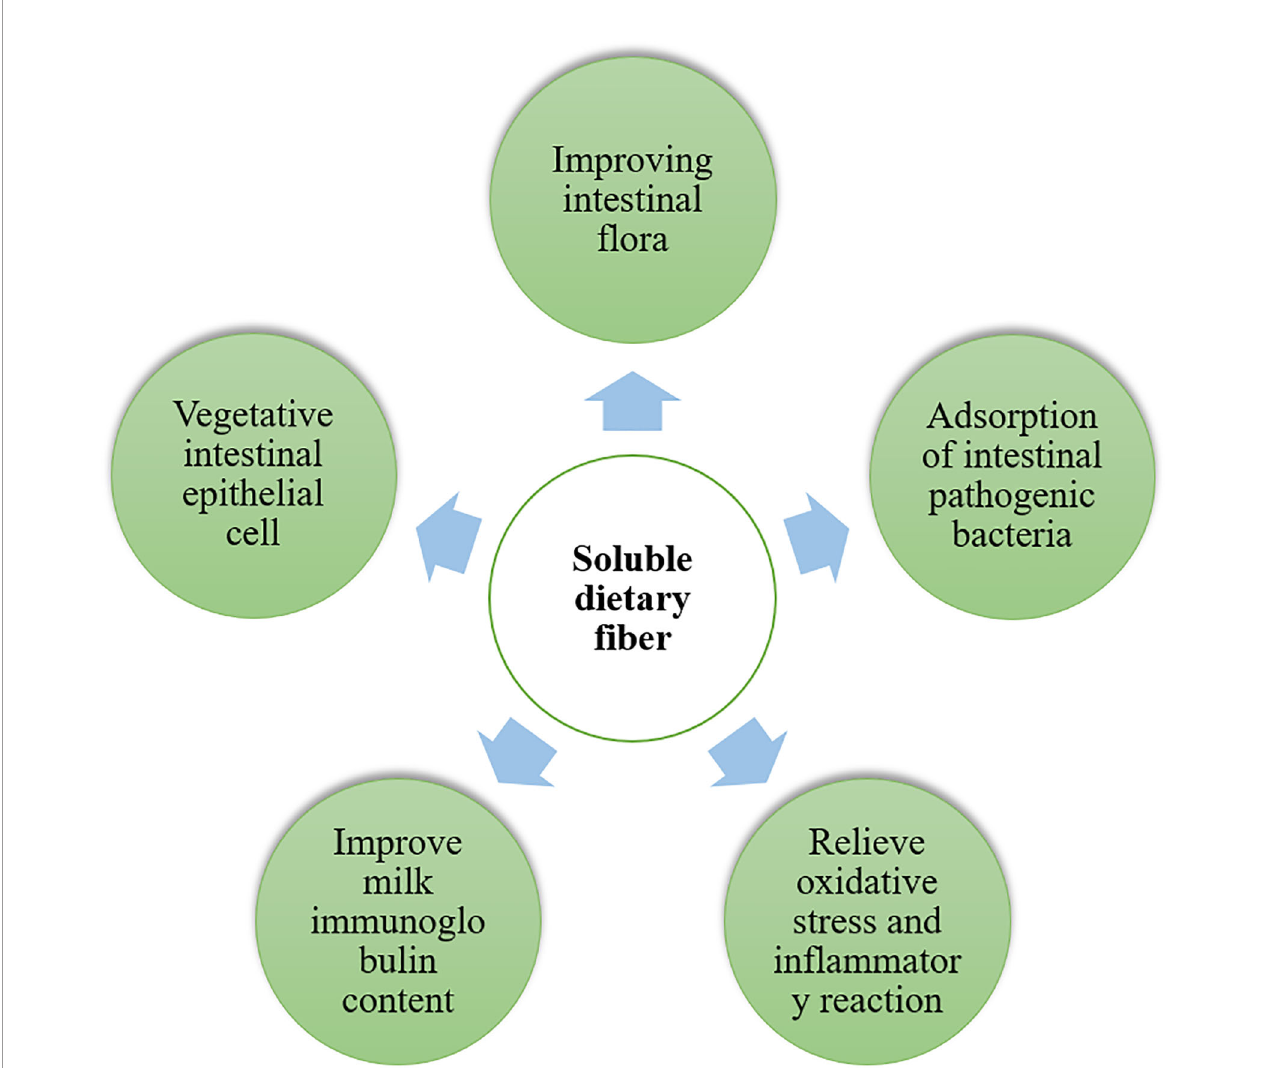
FIGURE 1 | The soluble dietary fi bers bene fi cial to intestinal health of sow, improves colostrum quality, enhance antioxidant capacity of sows and reduces in fl ammatory reaction of